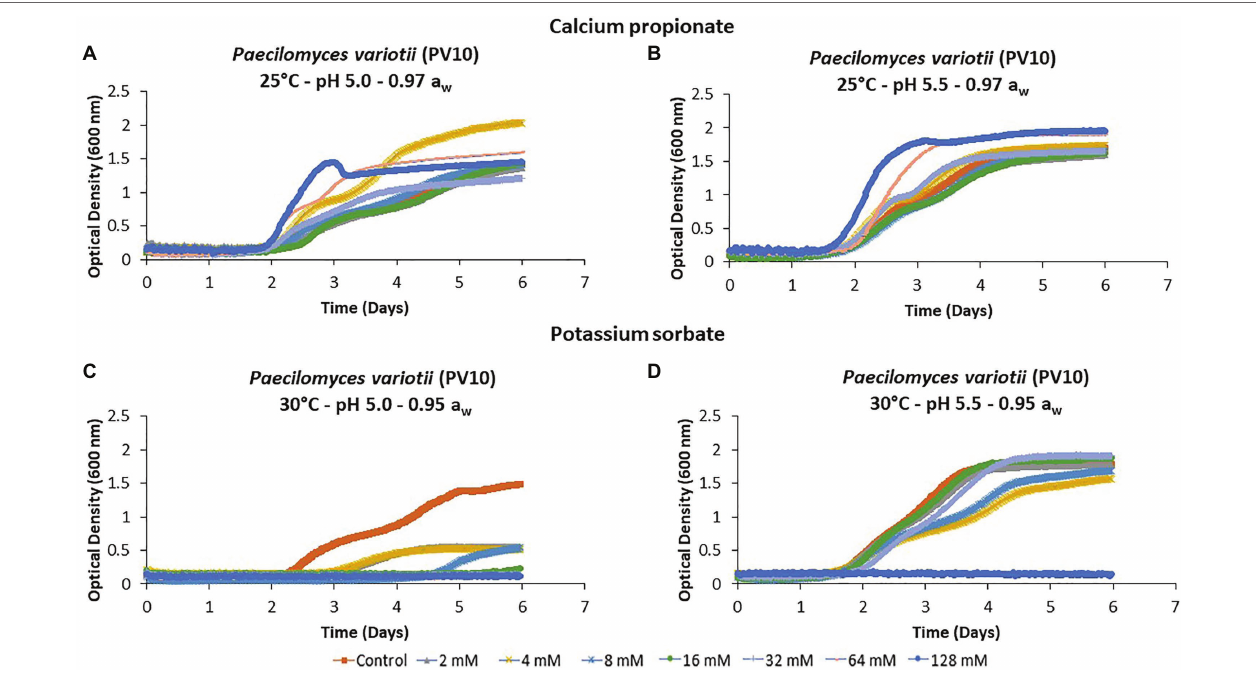
FIGURE 1 | Growth curves of Paecilomyces variotii (PV10) in (A,B) in the presence of calcium propionate (CP), and (C,D) potassium sorbate (PS) in semi-solid Yeast Extract Sucrose (YES) media containing different concentrations (0–128 mM) over 6 days incubation using the BioScreen (C) . Each curve represents the mean of five replicates.